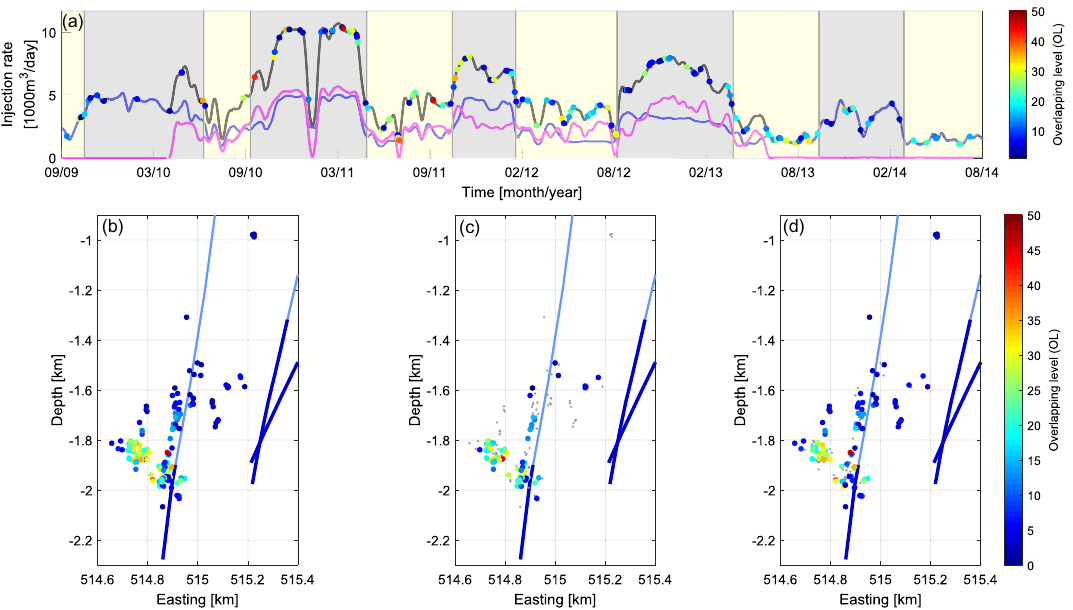
Figure 4. ( a ) ME occurrence in time in relation to injection rates into Prati-9 (blue), Prati-29 (magenta) and both wells (black). Colors indicate ME overlapping level. Peak and low injection rate periods are marked with gray and yellow, respectively. ( b – d ) Maps of ME overlapping level for: ( b ) all ME, ( c ) ME which occurred during low injection periods, ( d ) ME which occurred during high injection periods. Remaining ME are plotted as small grey